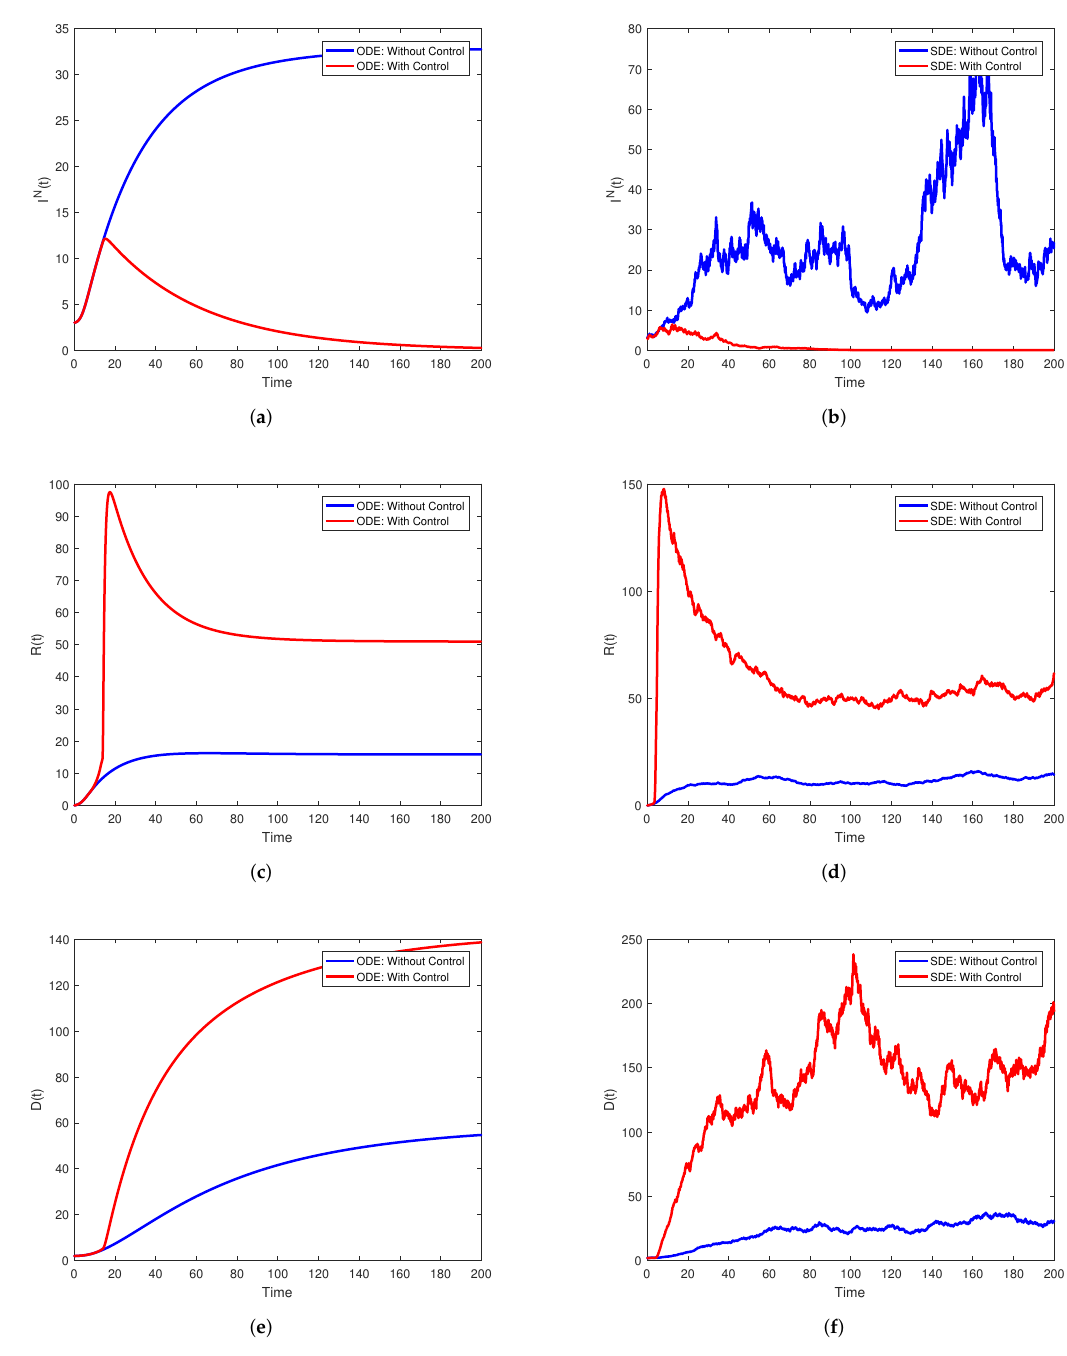
Figure 5. Simulations of ( I N ( t ) , R ( t ) , D ( t )) for the stochastic model (1) with its corresponding deterministic version, both with and without controls. ( a ) I N ( t ) in the case of the deterministic model both with and without control. ( b ) I N ( t ) in the case of the stochastic model both with and without control. ( c ) R ( t ) in the case of the deterministic model both with and without control. ( d ) R ( t ) in the case of the stochastic model both with and without control. ( e ) D ( t ) in the case of the stochastic model both with and without control. ( f ) D ( t ) in the case of the stochastic model both with and without